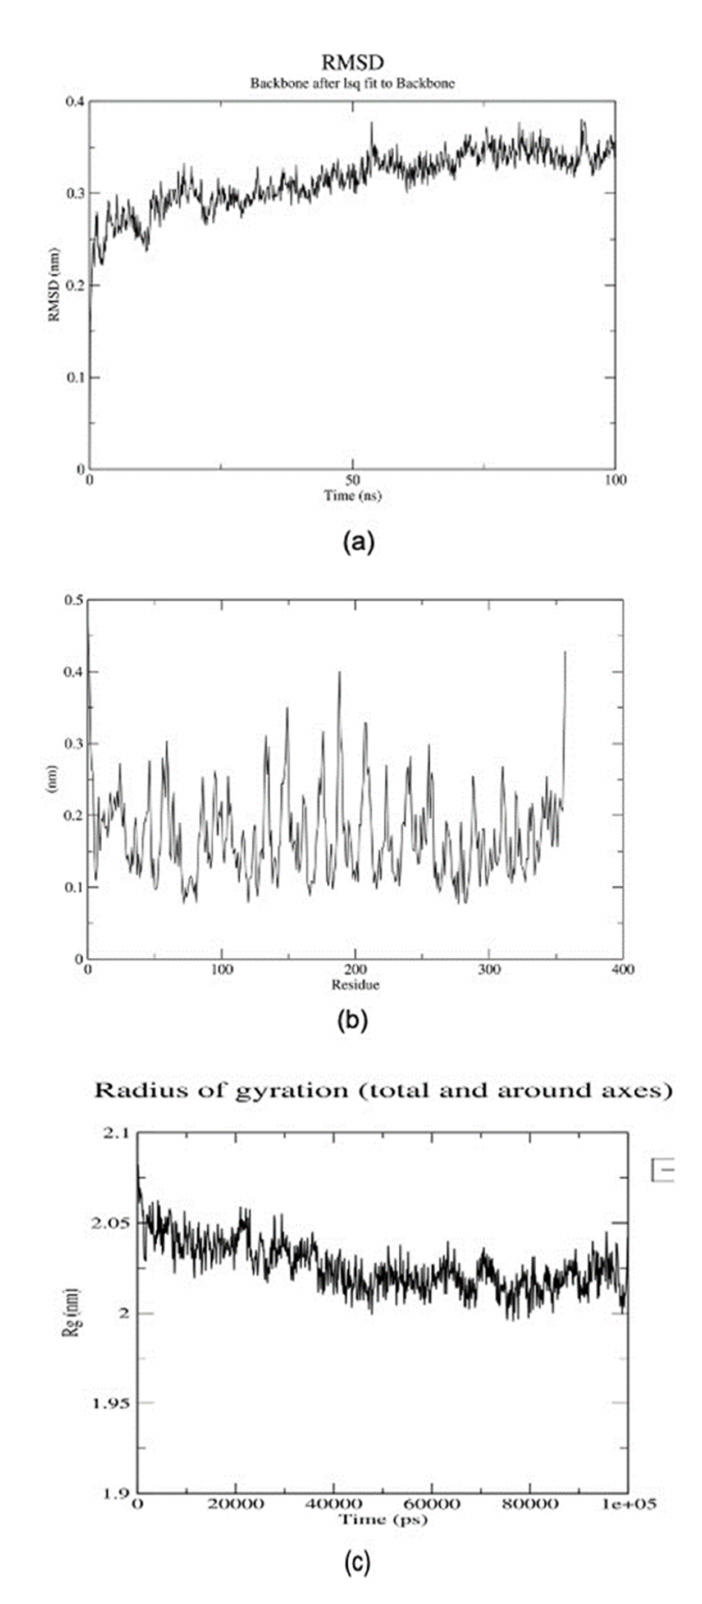
Figure 2. Graphical representations of Rg, RMSD, and RMSF of the MLN-CTD complex over a 100 ns MD simulation. ( a ) Graph of backbone RMSD (in nanometers (nm)) versus (time in nanoseconds (ps)). ( b ) Graph of RMSF (in nanometers (nm)) of the complex versus several residues. ( c ) The radius of the gyration graph of the complex (in nanometers (nm)) versus (time in picoseconds